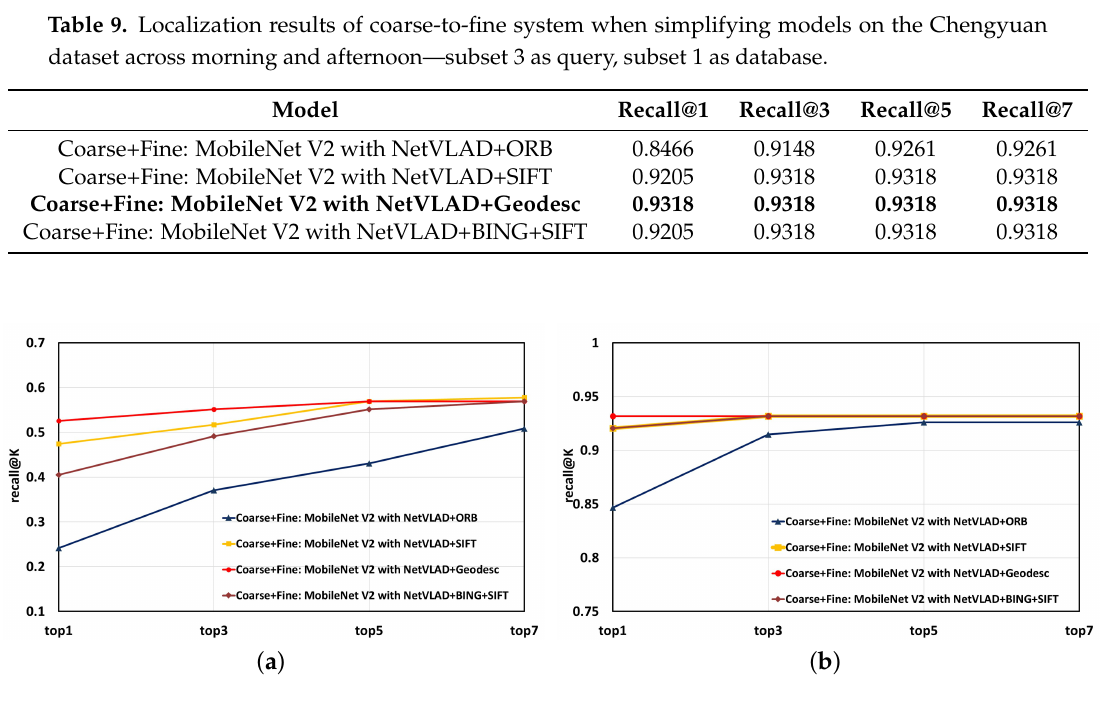
Figure 11. Line chart of matching results when simplify models on the Chengyuan dataset. ( a ) subset 2 as query and subset 1 as database; ( b ) subset 3 as query and subset 1 as query. (Coarse means the coarse stage, Coarse+Fine means combination of the coarse stage and the fine